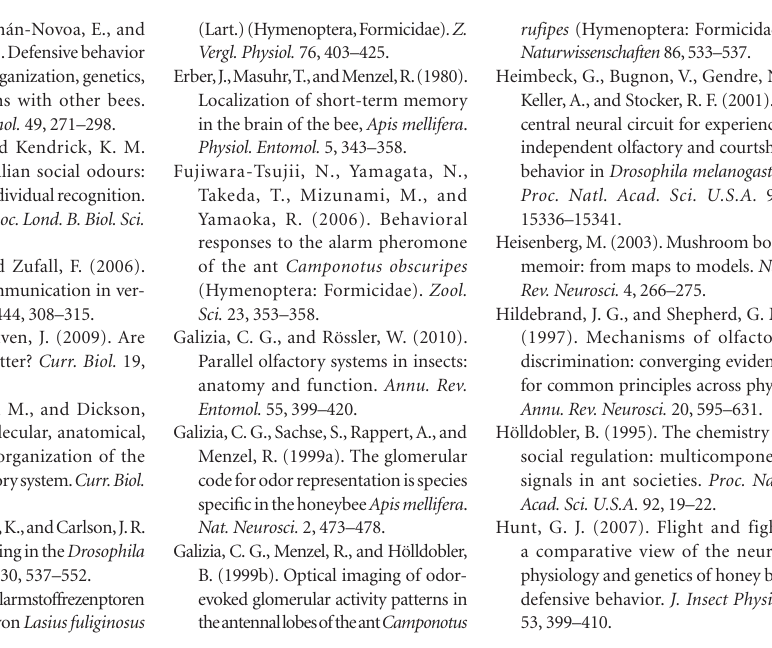
Figure 6 | Pheromone-sensitive wide-field protocerebral neuron. (A) Reconstruction of the neuron from confocal sections viewed ventrally. The soma is located at the boundary between the protocerebrum and the antennal lobe (a lob). The dendrites cover the vertical lobe (v lob), the medial protocerebrum (m pr) and a part of the lateral horn (l ho) and the lateral accessory lobe (lal). The axon takes a circular route around the pedunculus (ped) and